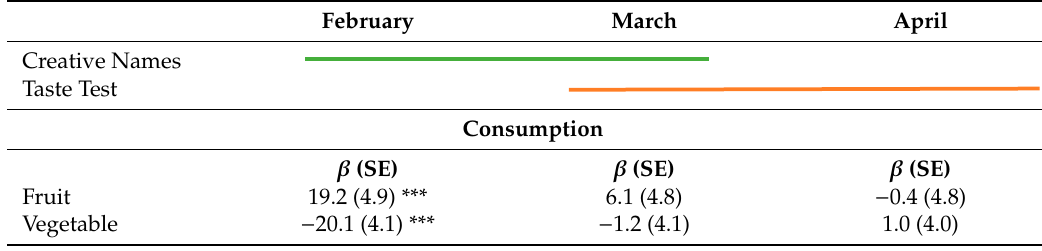
Table 4. Intervention component timeline and corresponding regression analyses examining changes in fruit and vegetable consumption over time at School 2.